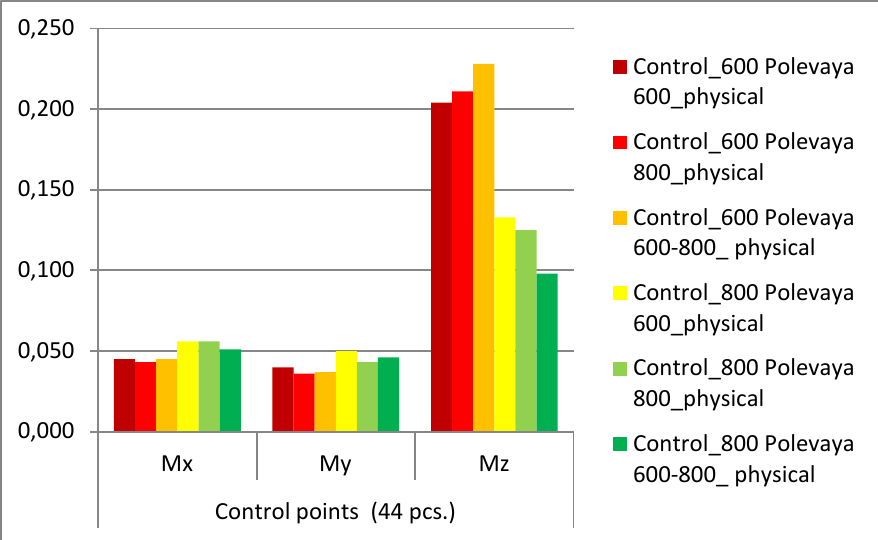
Figure 7. Assessment of accuracy of the triangulation on the basis of results of field calibration. PhotoScan (formula physical